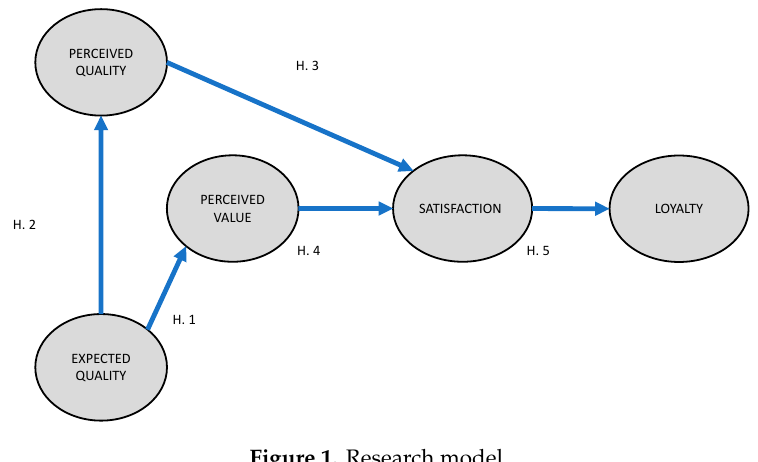
Figure 1. Research model.